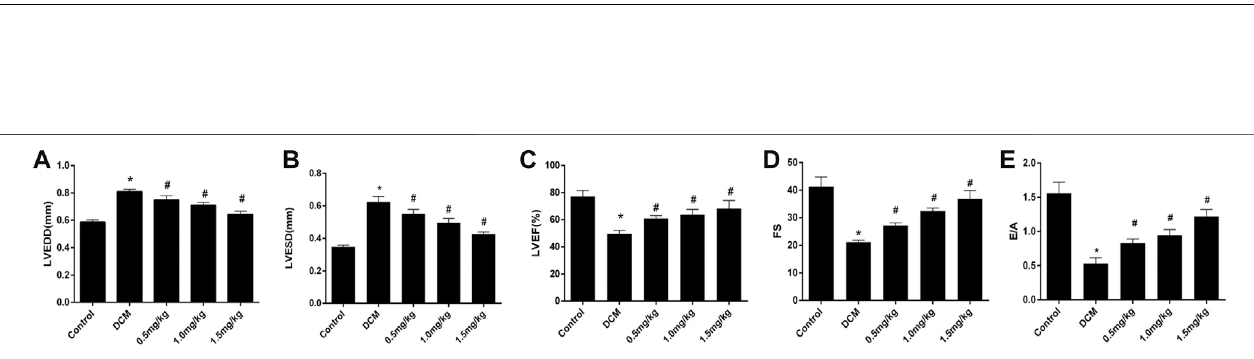
FIGURE 2 | Changes in metabolic indices in rats (n (cid:1) 10). (A) IPGTT and (B) IPITT were conducted in rats after four weeks of a HF diet. (C) TC, ( D ) TG, (E) FFA, (F) FBG, (G) FINS, and (H) ISI were measured using test kits. IPGTT, intraperitoneal glucose tolerance test; IPITT, intraperitoneal insulin tolerance test; TC, cholesterol; TG, triglyceride; FFA, free fatty acid; FBG, fasting blood glucose; FINS, fasting insulin; ISI, insulin sensitivity index. Values are mean ± SEM. * p < 0.05 compared with control group; # p < 0.05 compared with DCM group.